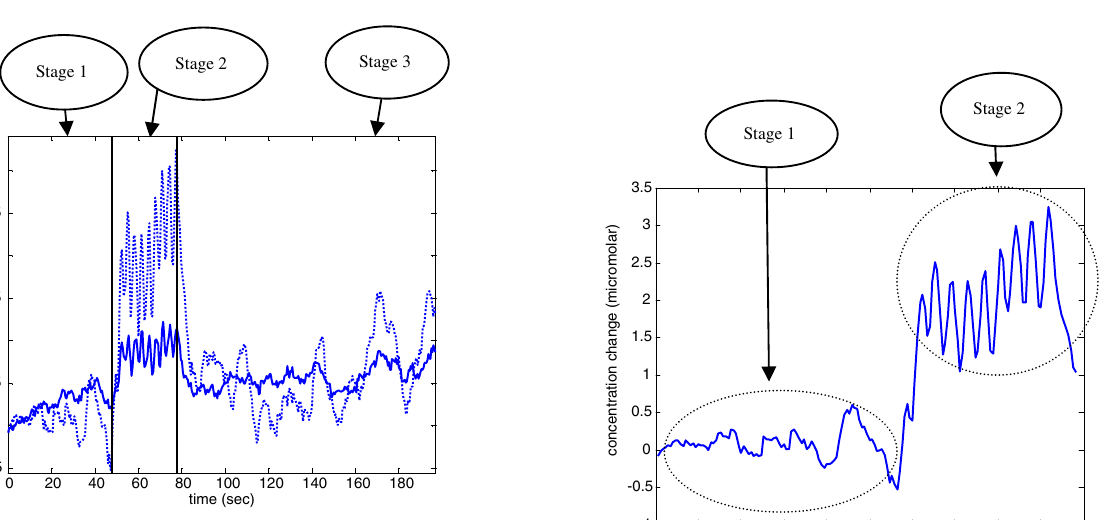
Fig. 1. Example of fNIR signals including three stages, stage 1 is rest, and then subject was moving his/her head during stage 2, and stage 3 is post motion, solid line was used for deoxy-Hb and the dotted line for oxy-Hb.